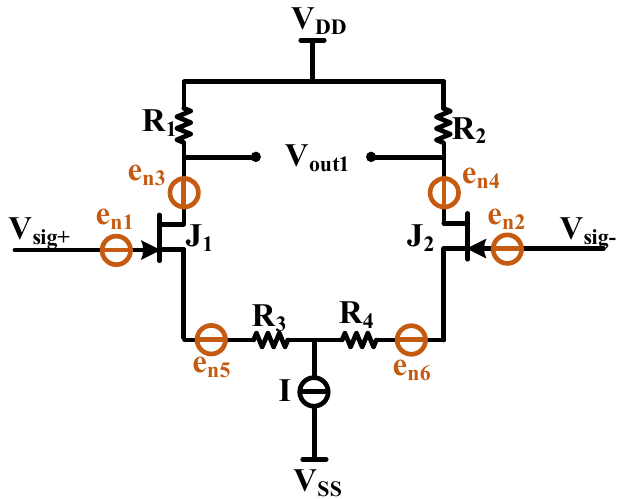
Figure 9. JFET differential circuit noise model.